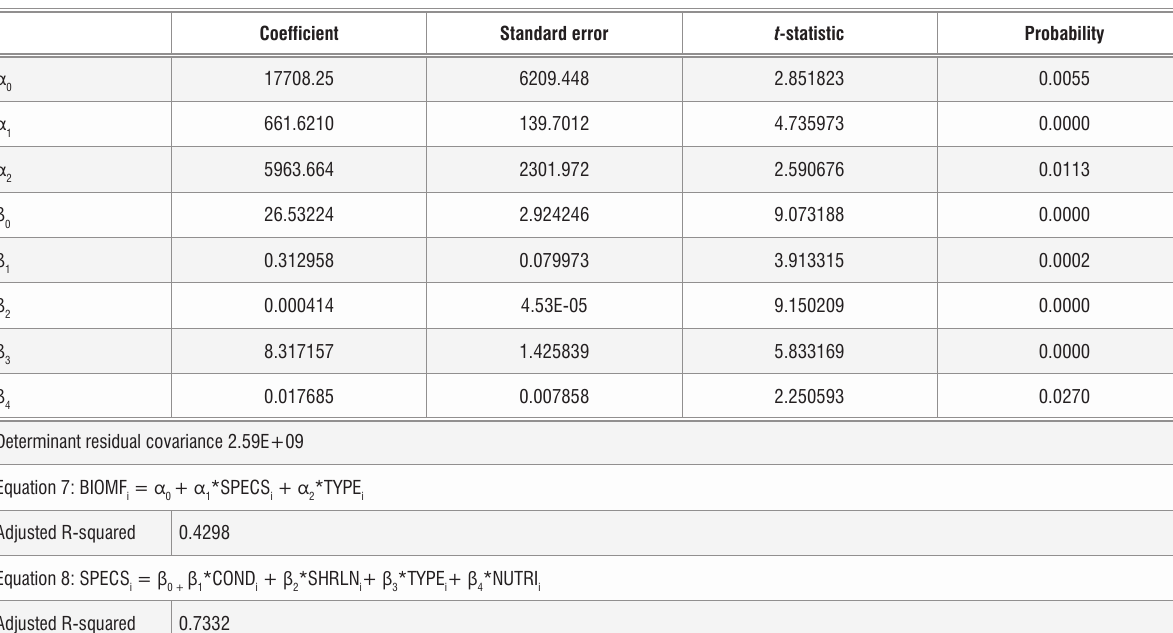
Table 3 : Two-stage least squares estimates of parameters of the system of Equations 7 and 8 for the linear model